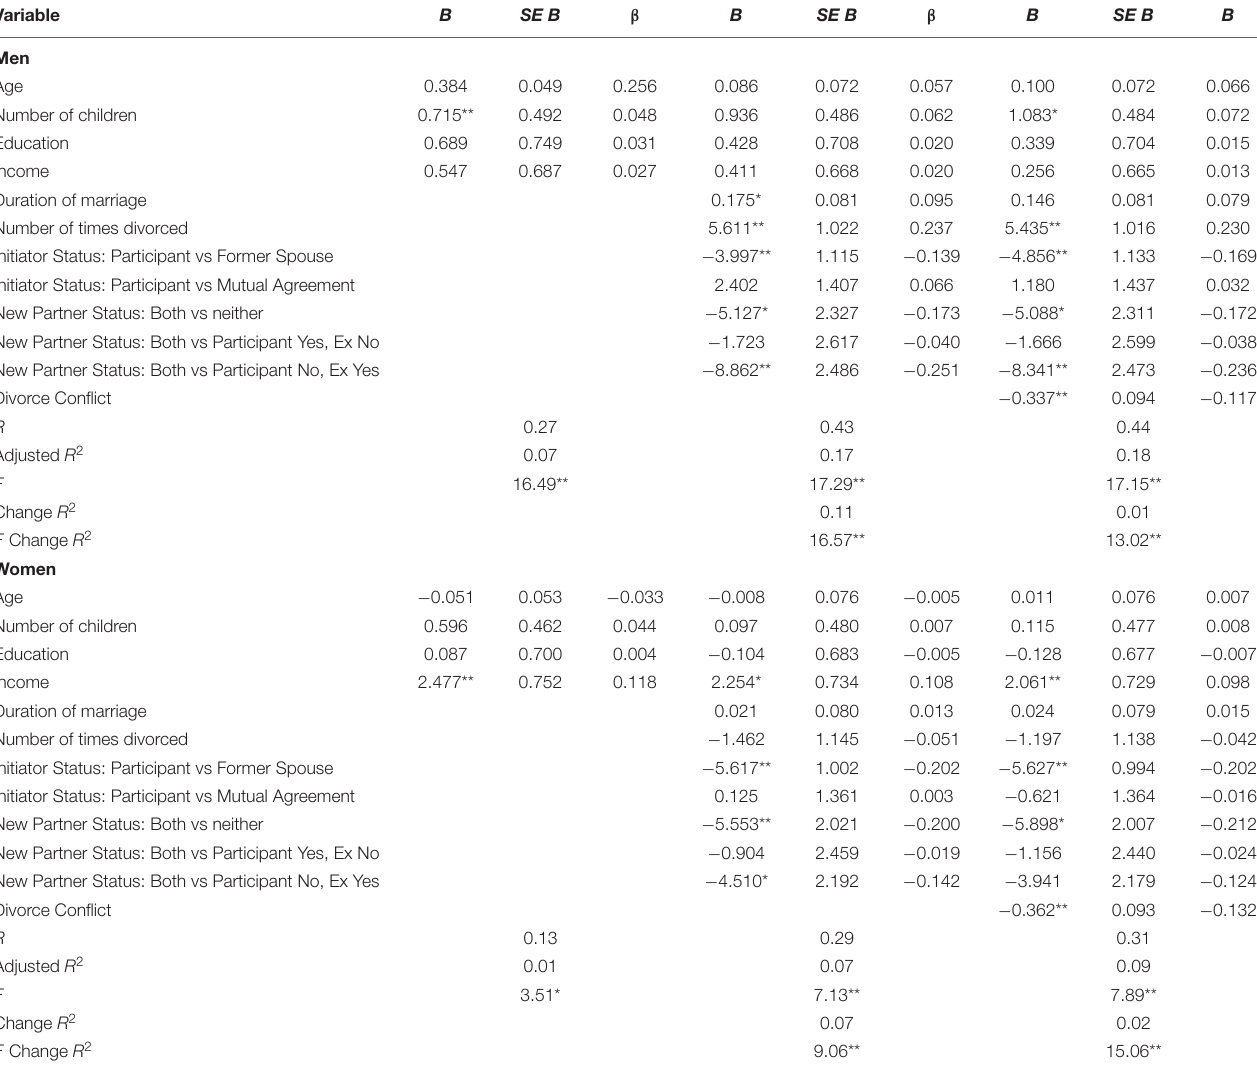
TABLE 4 | Multiple regression analyses predicting SF-36 mental health summary t